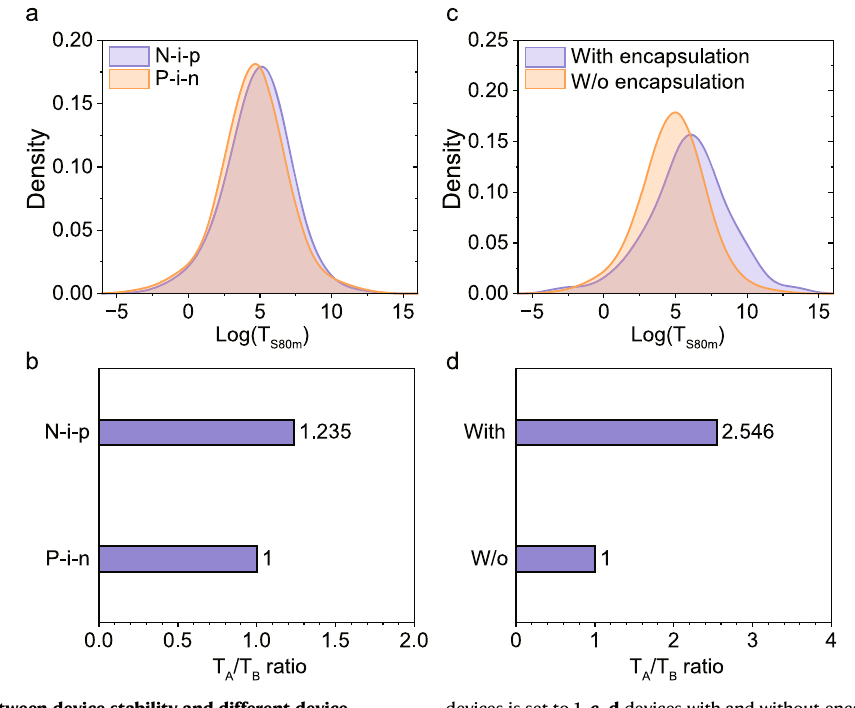
devices is set to 1. c , d devices with and without encapsulation, where the ratio of unencapsulated